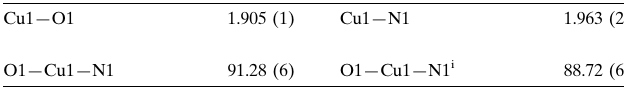
Selected geometric parameters (A˚ , (cid:1) ).